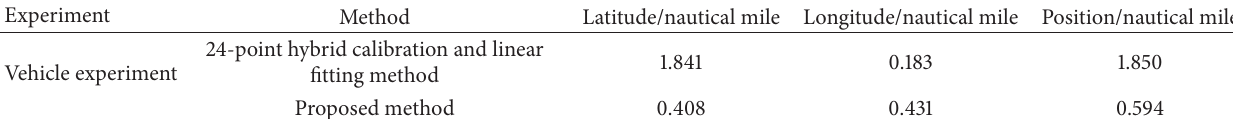
Table 1: The 3600 seconds position errors of inertial navigation in vehicle experiment.